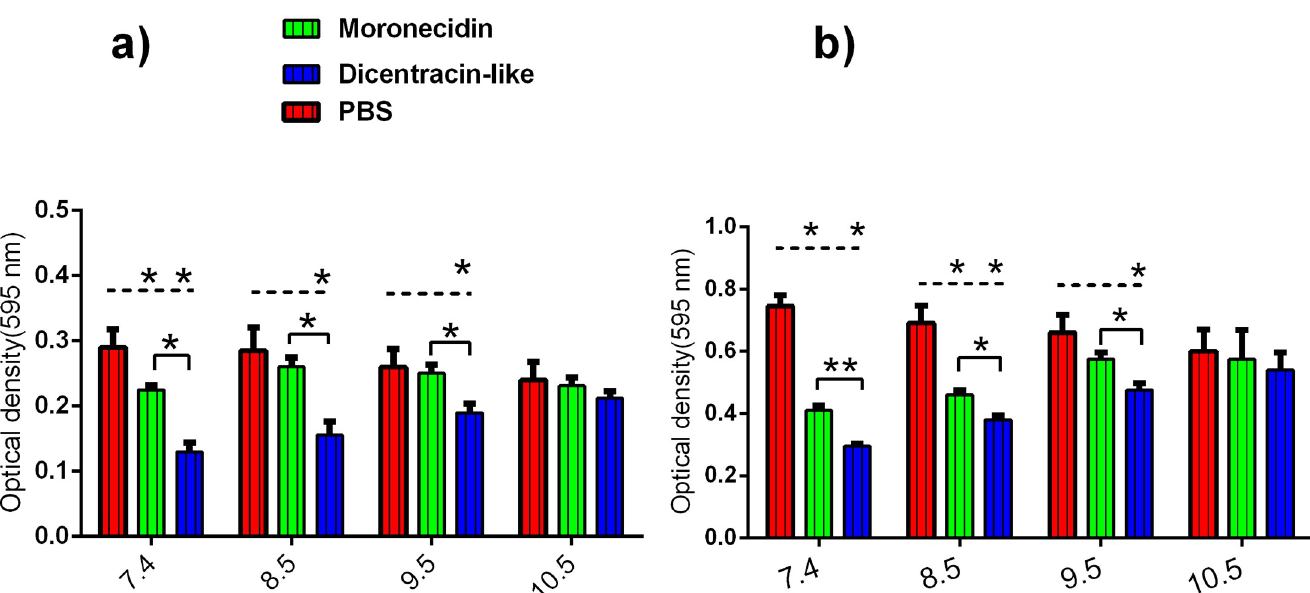
Fig 7. Evaluation of the pH effect on antiadhesive and antibiofilm activity of AMPs against E . faecalis . Inhibition of adhesion (a) and biofilm formation (b) was investigated in the presence of peptides at 1/32 × MIC.